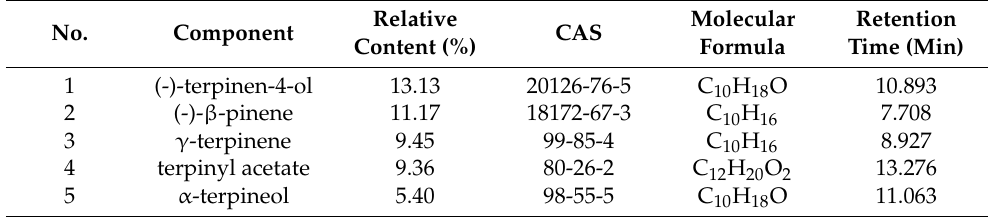
Table 3. Main components and contents of Zanthoxylum bungeanum essential